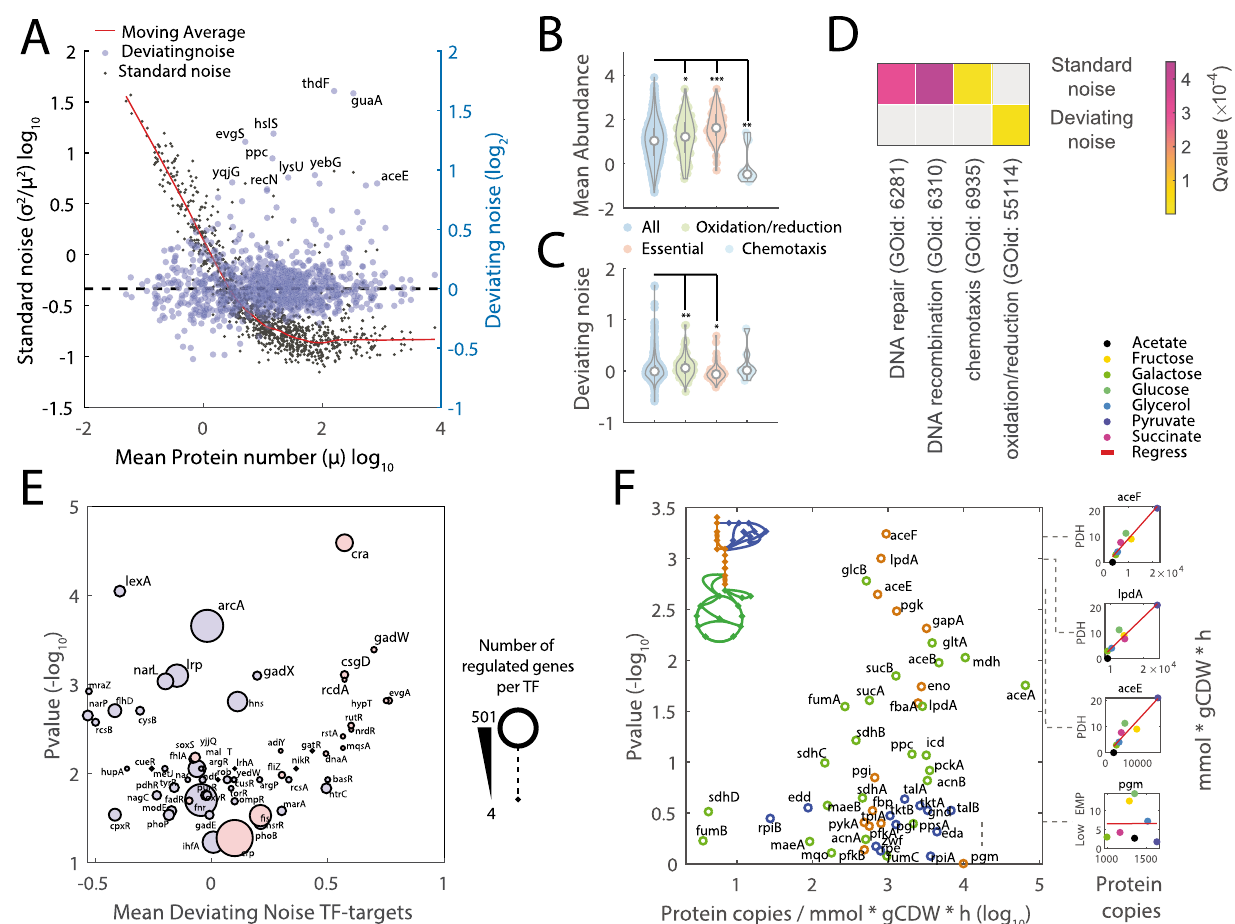
Fig. 1 Noise propagation to metabolism. A Time independent protein ( p ) abundance and noise from single-cells of E. coli 13 . Average copy number ( μ p ) vs. protein expression noise ( η = σ p 2 / μ p 2 , where σ p is the standard deviation) of 1018 proteins (gray dots). A moving average smoothing method is used to estimate average noise levels at different protein abundance ( (cid:1) η p ) (red line). Deviating noise (blue dots) is calculated as the ratio between the noise of individual proteins and average noise levels of proteins with similar abundance ( ε p ¼ η p = (cid:1) η p ) (Supplementary materials and Supplementary Data 1). Highlighted with gene names, proteins that exhibit the highest deviating noise levels. The black dashed line corresponds to zero deviating noise. B , C Distributions of average protein abundance and deviating noise levels. Asterixis indicate signi fi cance, two-tailed t -test: * p value ≤ 0.05, ** p value ≤ 0.01, *** p value ≤ 0.001. D Gene ontology enrichment (http://geneontology.org/) reporting biological processes that are signi fi cantly (permutation test with Storey correction q value<0.001) enriched for proteins with high deviating or standard noise levels. E For each transcription factor (TF) we estimated the average protein deviating noise of target regulated genes and the signi fi cance of the enrichment for target regulated genes with large deviating noise levels. TFs regulating proteins with a positive or negative median deviating noise is colored in red and blue, respectively. Size of the dot scales with the number of target-regulated genes. F For each enzyme in central metabolism we used ordinary least square regression analysis to estimate the proportionality and signi fi cance between protein copy number 29 and corresponding fl ux rates 30 across seven different conditions. Enzymes are colored by pathway: orange- glycolysis, blue-pentose phosphate pathway, green-TCA, as indicated by the small schematic on the upper left corner (see Fig. S1 for full